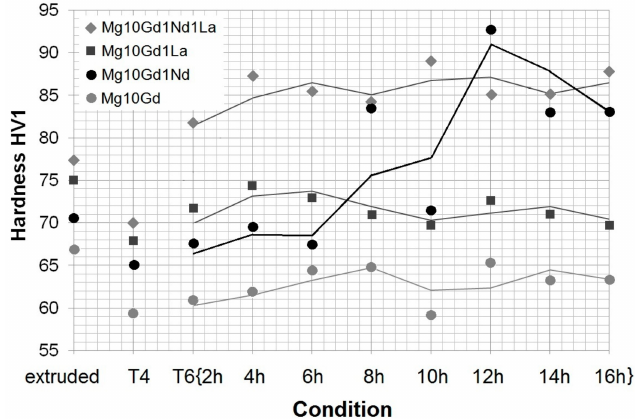
Figure 5. Effect of adding Nd or/and La on hardness during precipitation hardening.